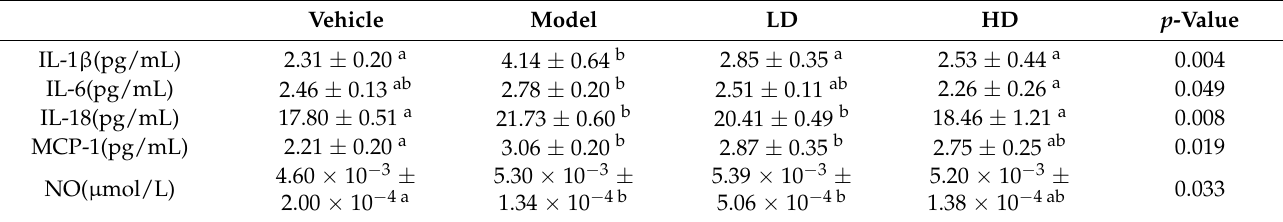
Table 1. Effects of SAVEP on inflammatory cytokines